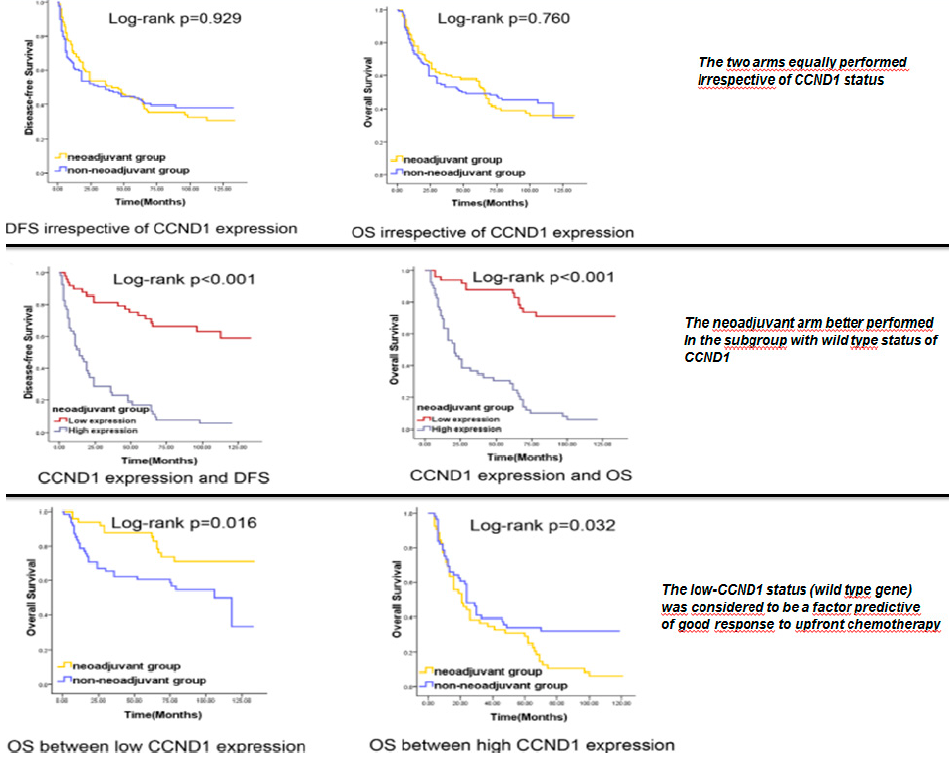
Figure 4. The wild type status for CCND1 is sharply linked to the HPV positivity in HSNCC. It is strongly related to the good response to sequential chemoradiotherapy and with the poor response Feng Z et al. PLoS One. 2011 , 6 , e26399 [62]. CCND1: cyclin D1; DFS: disease free survival; OS: overall disease free survival; OS: overall survival.